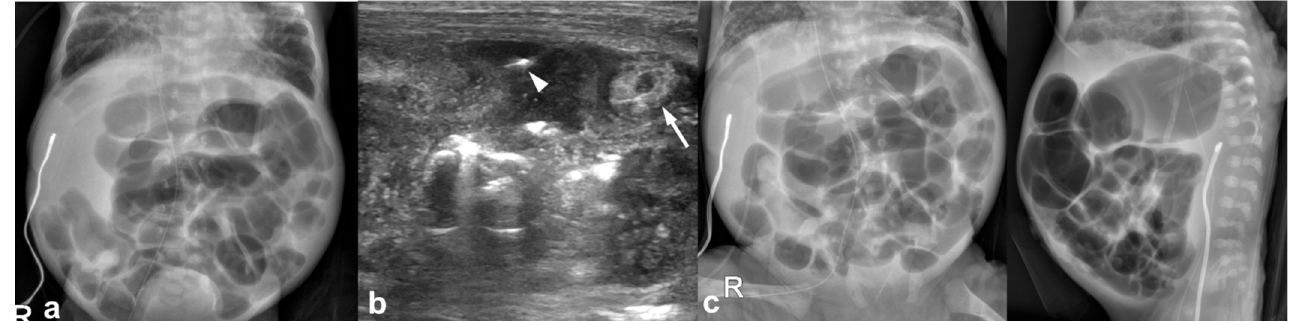
Figure 1. 22-day-old girl (born at gestational age of 25 weeks and 3 days) with US-detected perforated necrotizing enterocolitis without radiographic pneumoperitoneum; this infant survived. ( a ) An abdominal radiograph obtained 7 h before US shows ileus with elongated loops and no pneumoperitoneum. ( b ) Preoperative US images show bowel wall thickening (arrow) and free air within the complicated ascites (arrowhead). ( c ) Preoperative abdominal radiographs obtained 30 min after US show no pneumoperitoneum.